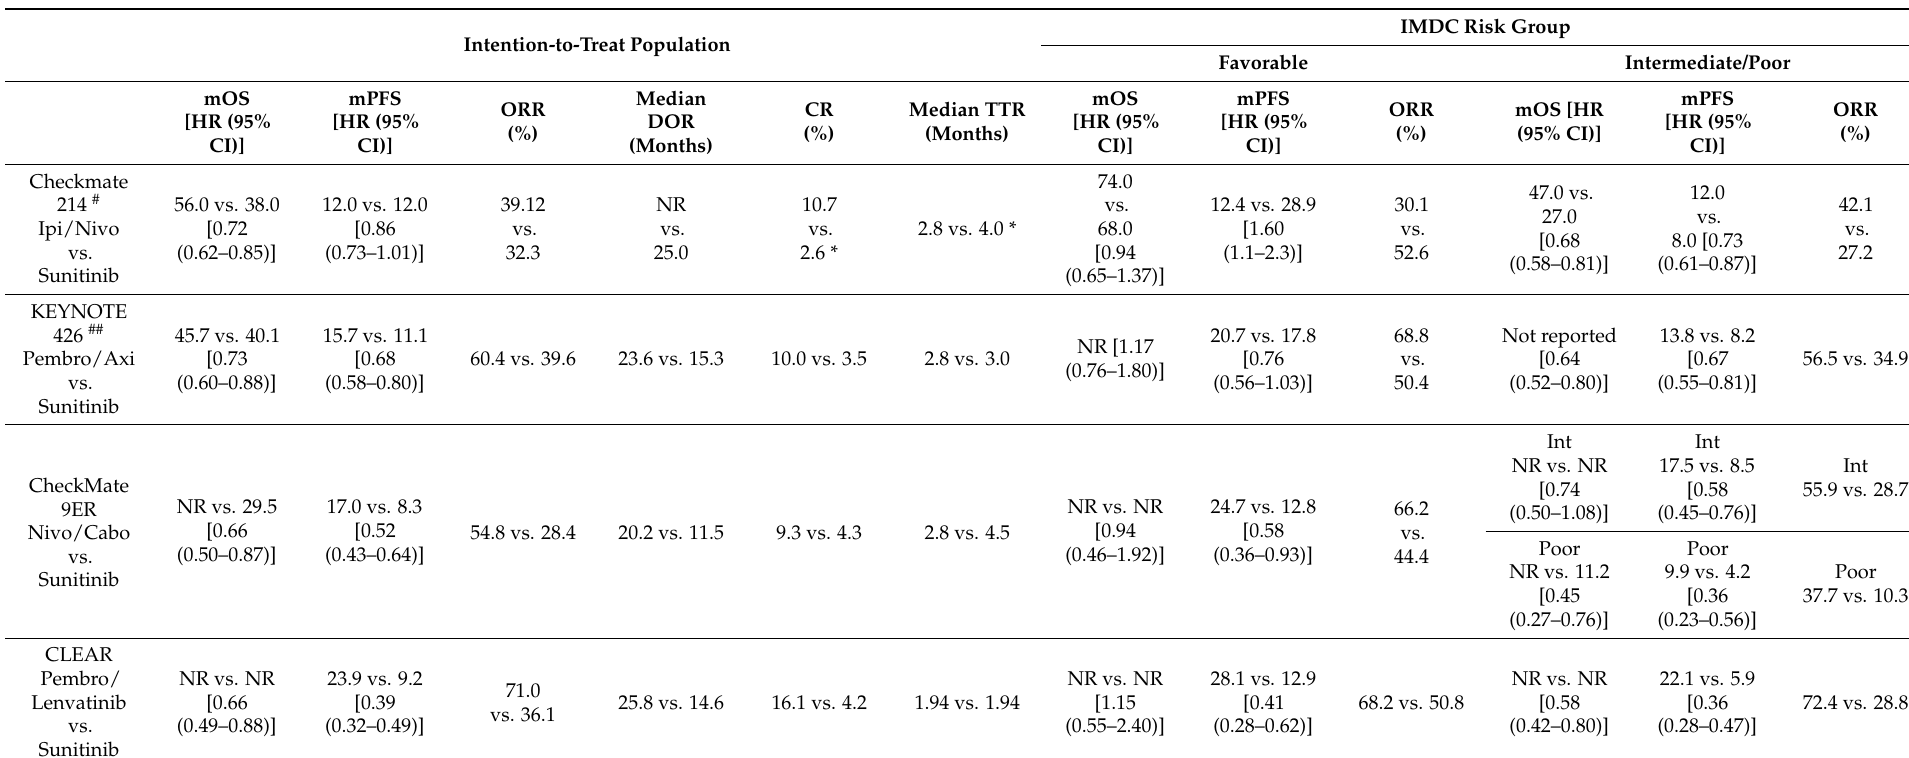
Table 2. Front-line immuno-oncology (IO)-based combination therapies in metastatic clear cell RCC with extended follow